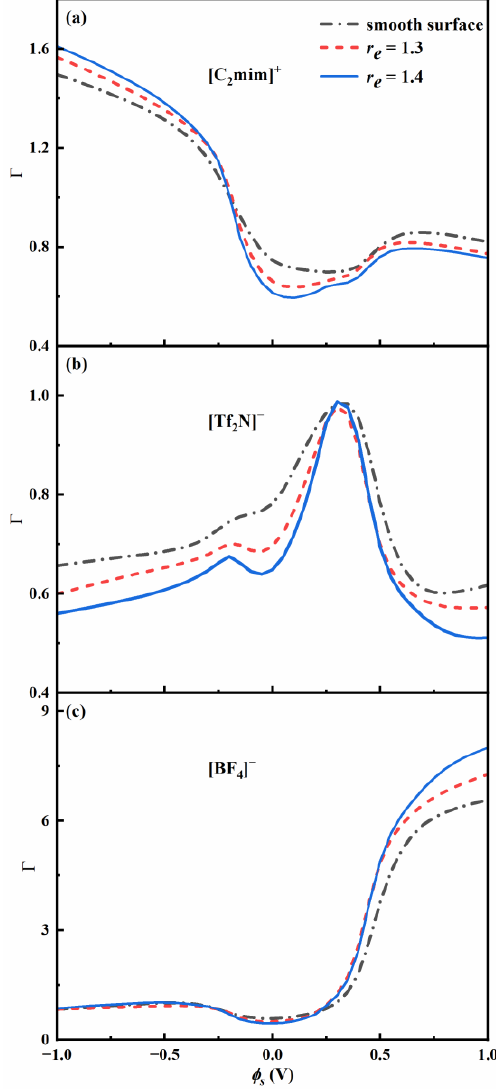
Figure 6. Partition coefficient of ions as a function of φ s , the bulk molar fraction X BF4 is 0.2. At negative potential, the cations become enriched in the nanopore, and their average density monotonically increases with absolute potential. When the surfaces are sufficiently negatively charged, ρ of all anions decreases with increasing voltage. As the surface roughness increases, ρ of cations increases, and ρ of larger anions [Tf 2 N] − decreases. Nevertheless, the average density of smaller anions [BF 4 ] − is almost independent of surface roughness. Overall, the adsorption of cations and the exclusion of larger anions are significantly enhanced by roughness.